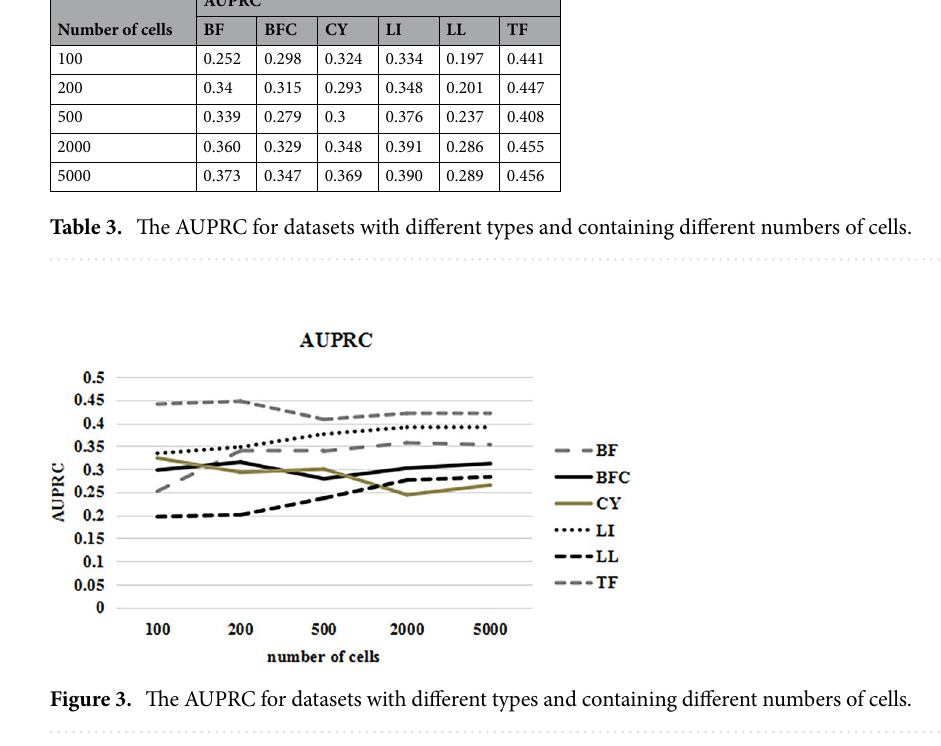
Number of cells